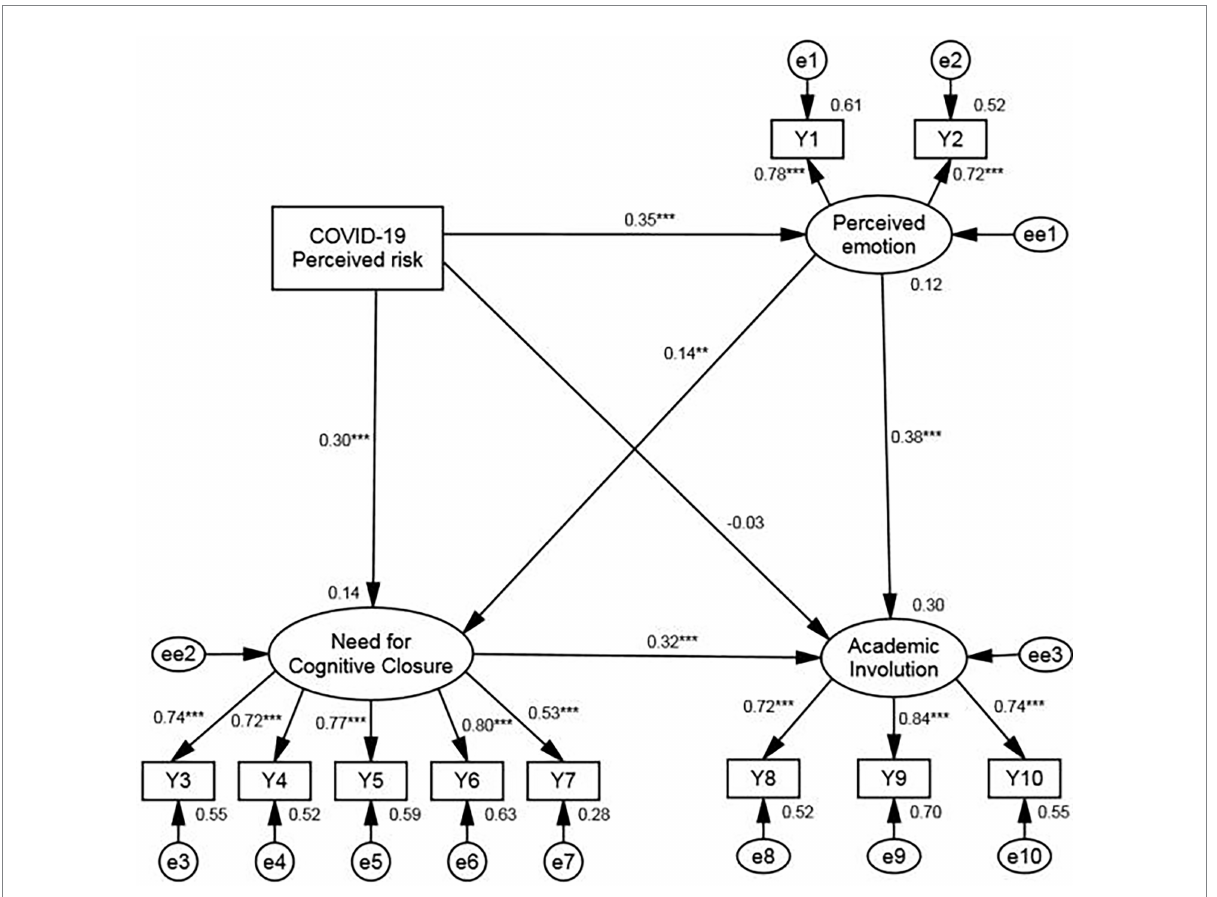
FIGURE 2 Results of path analysis with latent